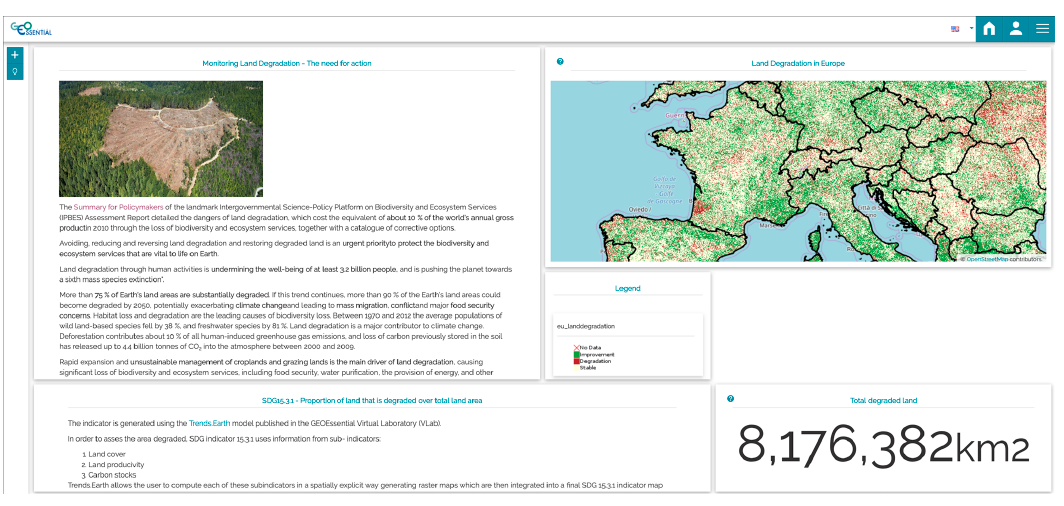
Figure 11. GEOEssential Dashboard.